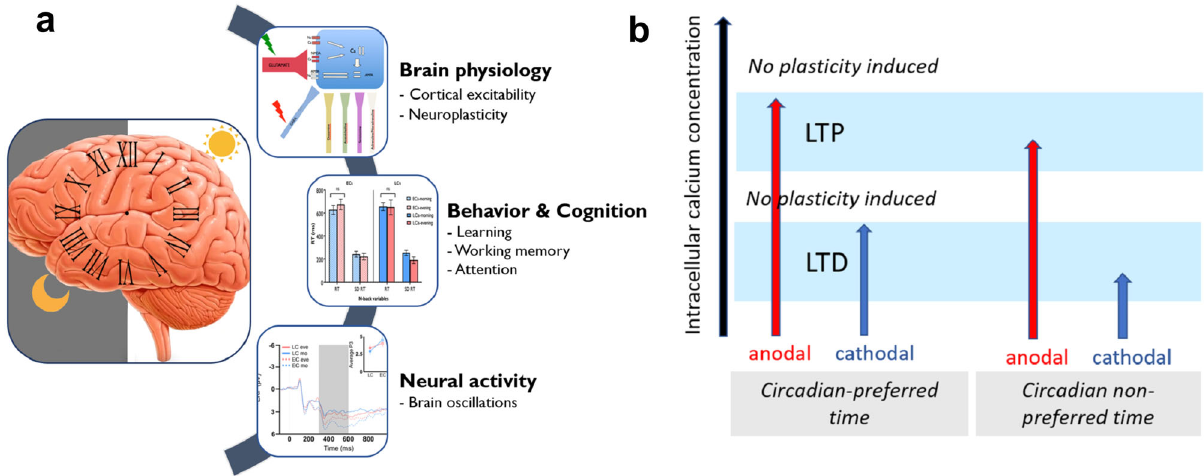
Fig. 7 Chronotype, human brain physiology and cognition. a A schematic illustration depicting the converging impact of chronotype on brain physiology, behavior, and cognition. b Proposed mechanism of the neuroplasticity induction at circadian-preferred and non-preferred time based on the association between intracellular calcium concentration ( x axis) and induction of tDCS-induced neuroplastic changes. Gradual enhancement of calcium concentration can either induce LTD, LTP, or no plasticity. The LTP-like plasticity induced by tDCS is linked to higher intracellular calcium concentration while LTD-like plasticity induced by tDCS is linked to a lower intracellular calcium concentration. It can be assumed that intracellular calcium concentration at the optimal time of the day is at an optimal level leading to stronger tDCS-induced LTP/D-like plasticity. This would be at least partially related to the higher glutamatergic and lower GABAergic activation at the circadian-preferred time, shown by cortical excitability data. LTP long-term potentiation, LTD long- term